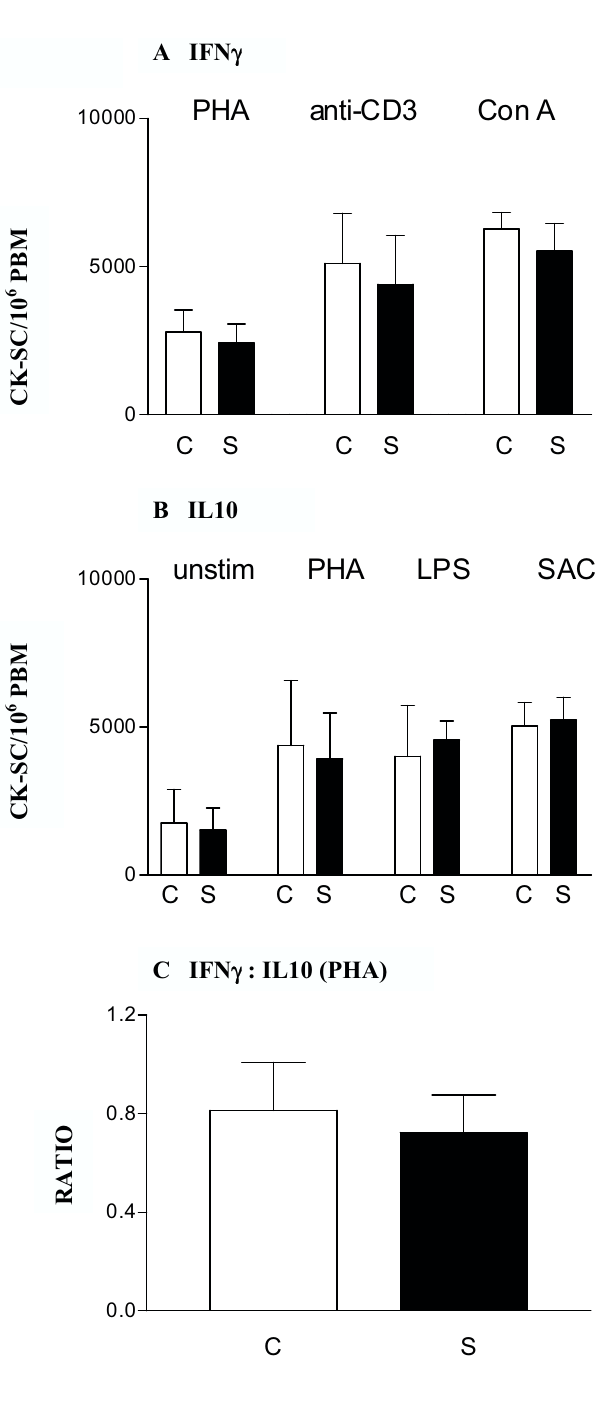
Figure 5 IFN γ production (A), IL10 production (B) and IFN γ :IL10 ratio (C) at 14 weeks after training in subjects who continued (C) Qigong practice beyond 14 weeks and those who stopped (S) at 10